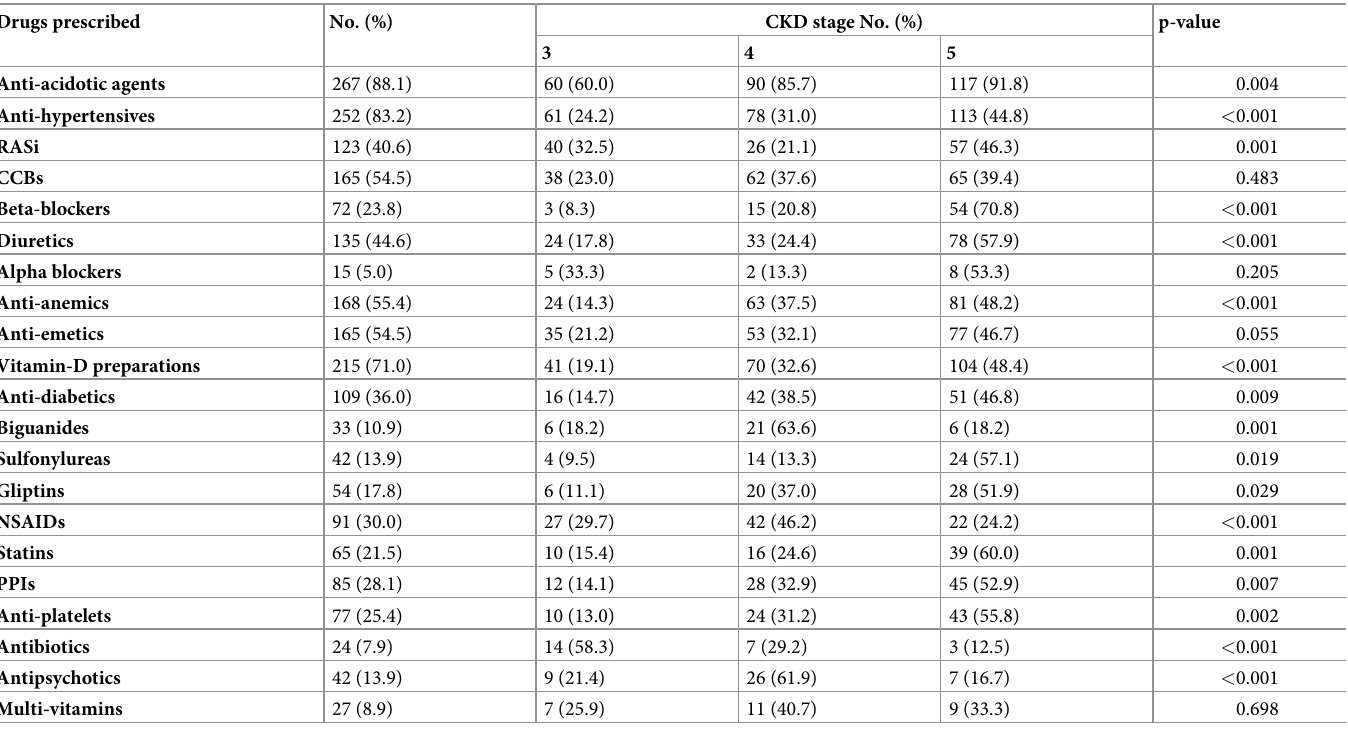
Table 3. Drugs prescription